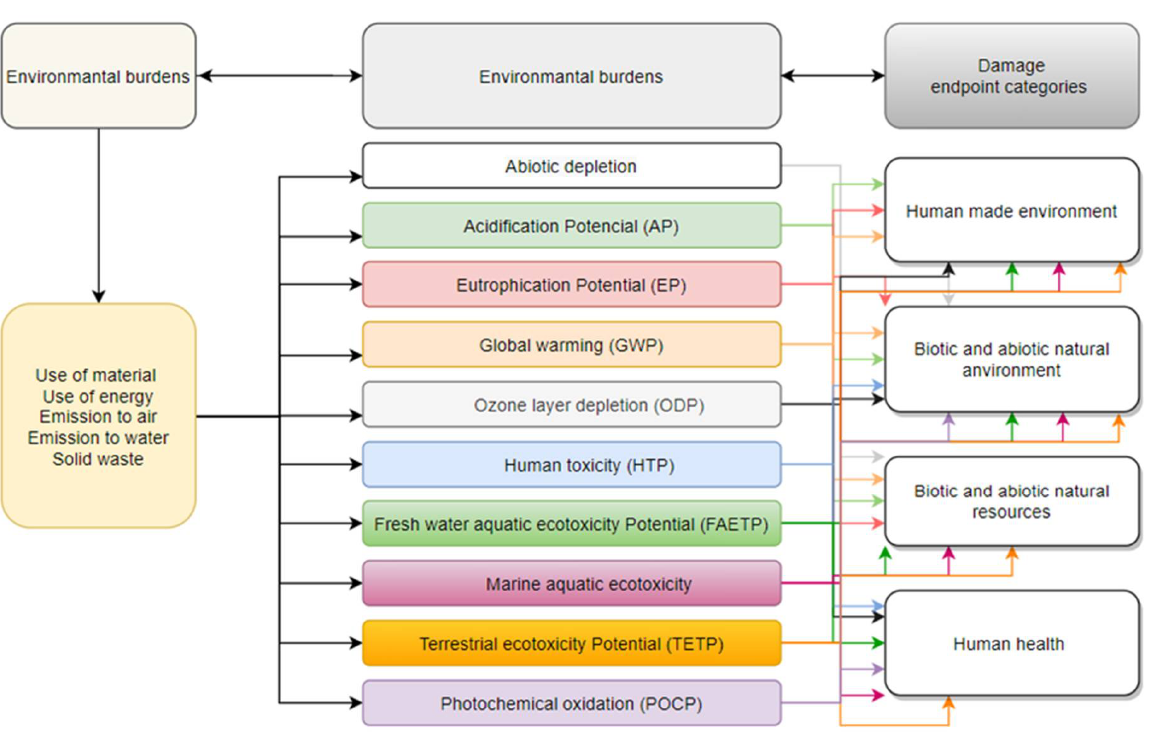
Figure 3. CML 2 baseline 2000 method map.